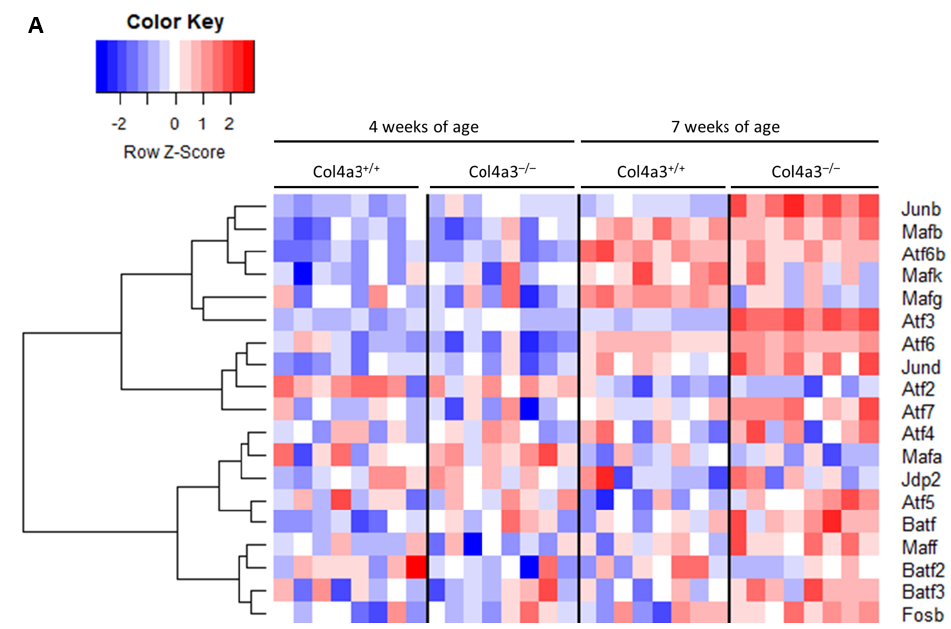
Figure 9. AP1 Heatmap. ( A ) Heatmap with unsupervised hierarchical cluster analysis of AP1 genes in kidneys of 4 and 7 week old Col4a3 –/– and wild-type mice ( n = 8 per group).